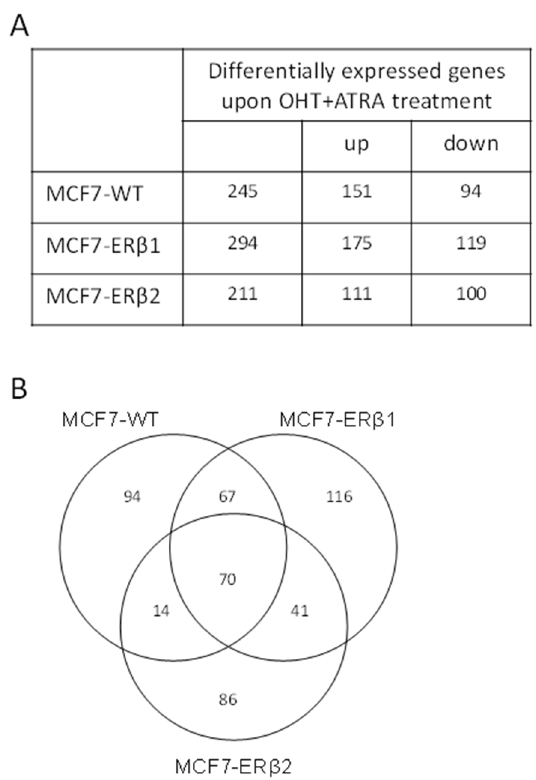
Figure 6. Global transcriptional profile of MCF7-WT, MCF7-ER β 1 and MCF7-ER β 2 cells in response to treatment with OHT in combination with ATRA. ( A ) The number of differentially expressed genes in MCF7-WT, MCF7-ER β 1 and MCF7-ER β 2 cells upon treatment with OHT (100 nM)+ATRA (50 nM). ( B ) Venn diagram representing the overlap between differentially expressed genes in MCF7-WT, MCF7-ER β 1 and MCF7-ER β 2 cells. OHT, 4-hydroxytamoxifen; ATRA, all-trans retinoic